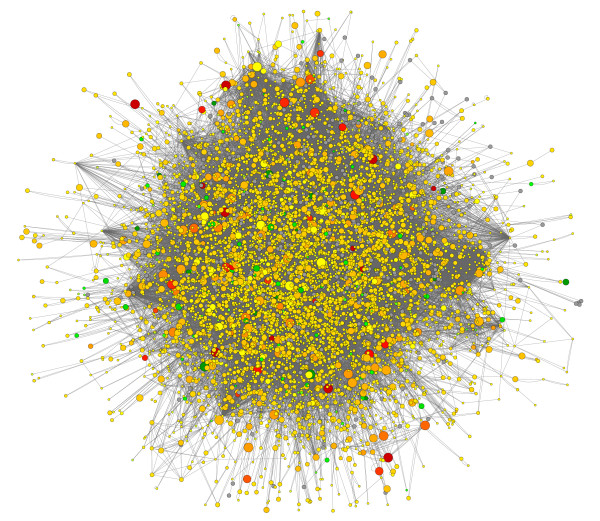
Expression Network. Protein-protein interaction network overlaid with sticky mutant expression data. Red indicates genes that are up-regulated in sticky mutant compared to wild-type and green indicates down-regulation. Yellow nodes represent genes with little to no change in expression and gray nodes represent genes that could not be assigned expression data. Node size indicates the significance (i.e. p-value) of the change in expression, where larger nodes are more significant and smaller nodes are less significant.